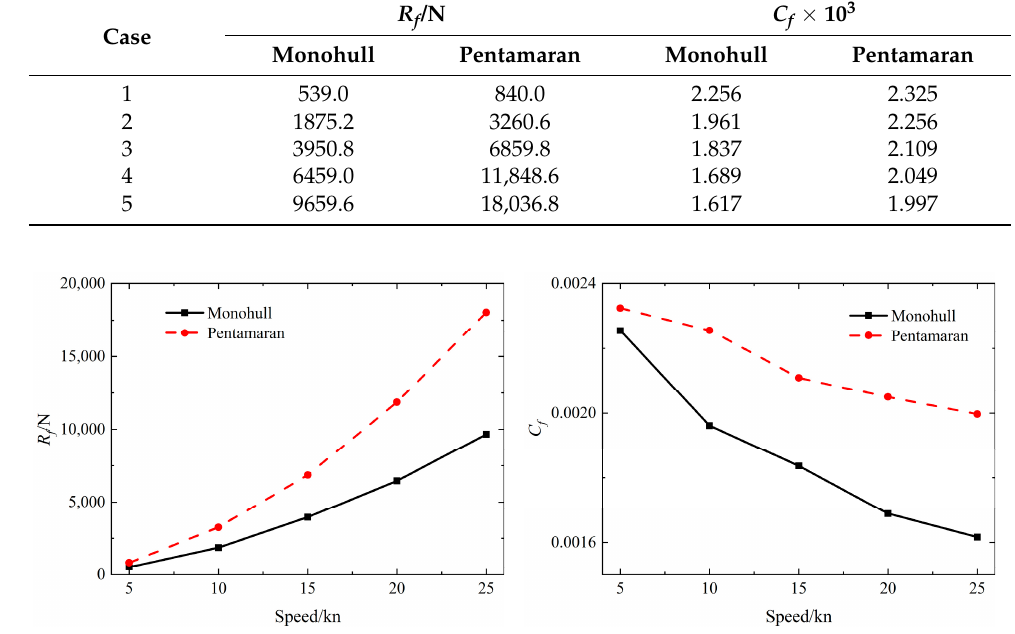
Figure 15. R f and C f curves.